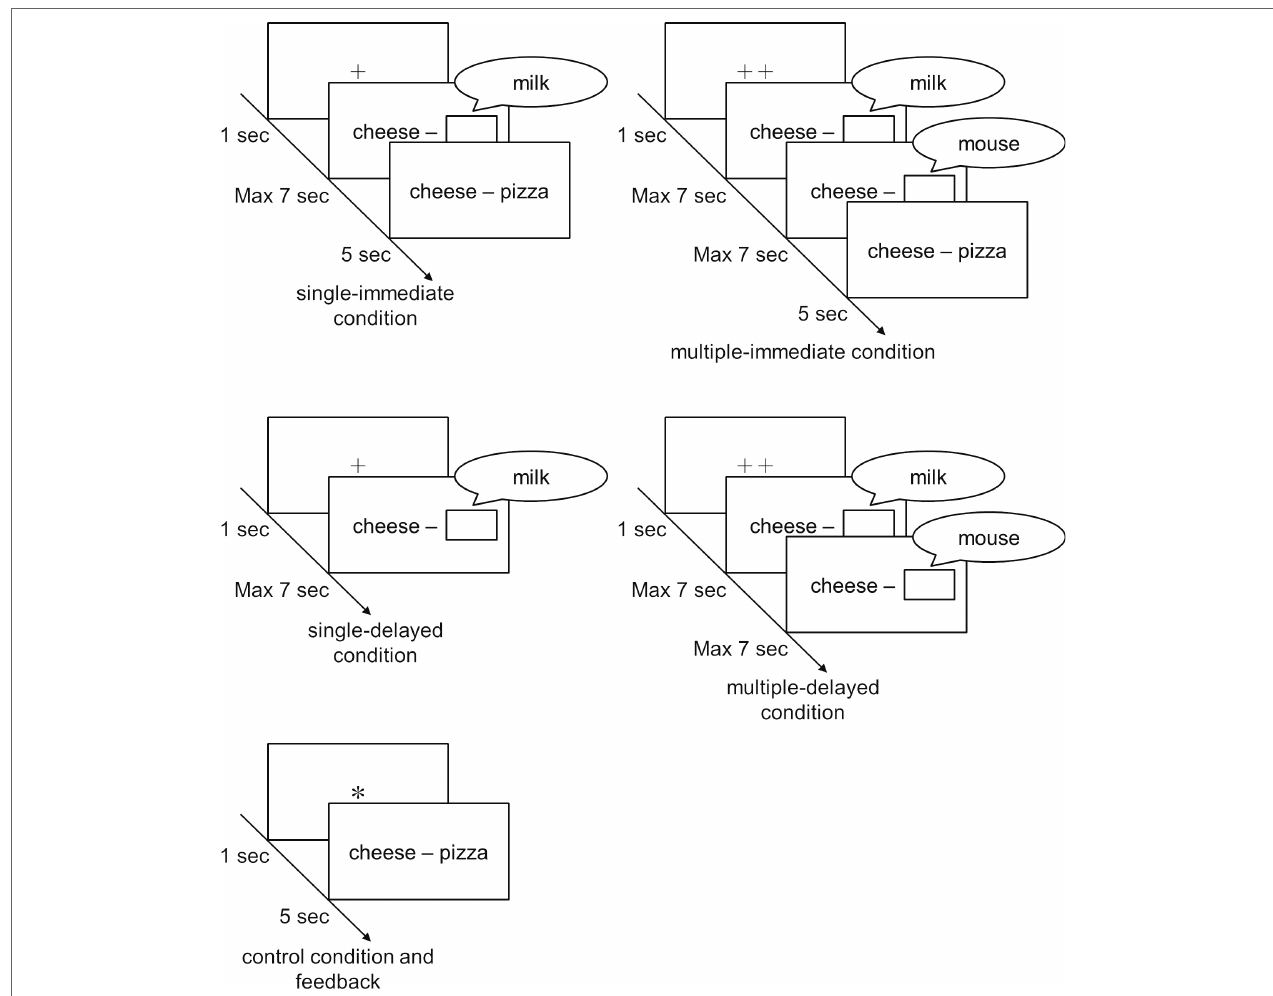
FIGURE 1 | Procedures for each condition at the word learning